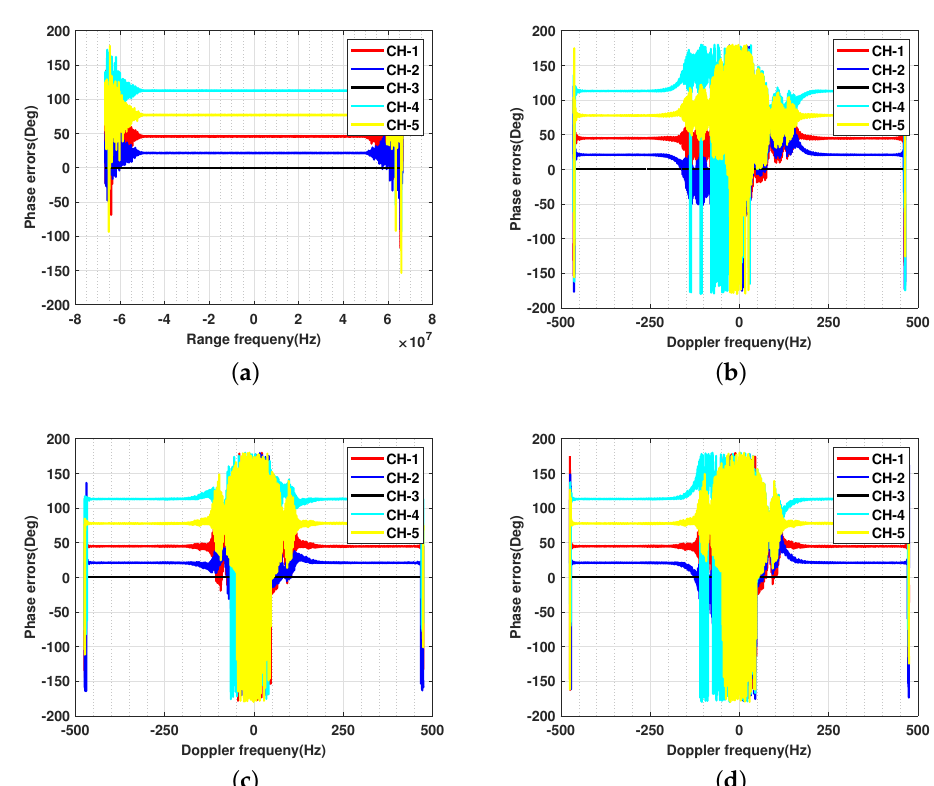
Figure 7. The results of channel phase error estimation. ( a ) Estimated result using the TDCM. ( b ) Estimated result using the OSM. ( c ) Estimated result using the MDVR. ( d ) Estimated result using the proposed method.